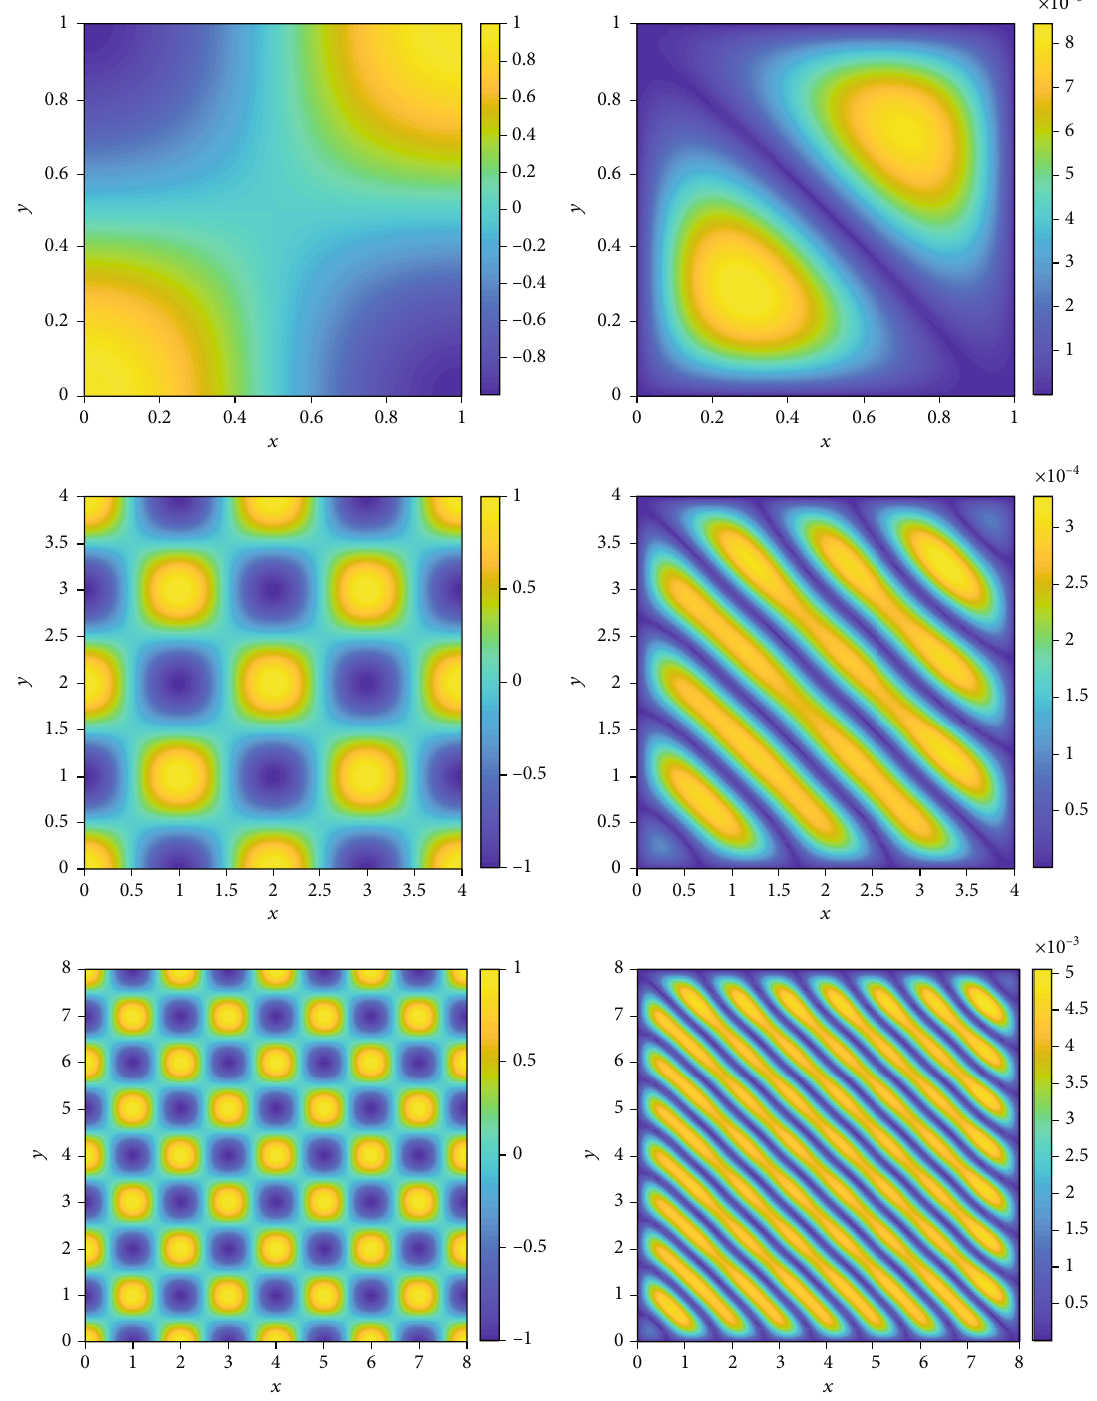
Figure 1: Approximate solution and its absolute error on square